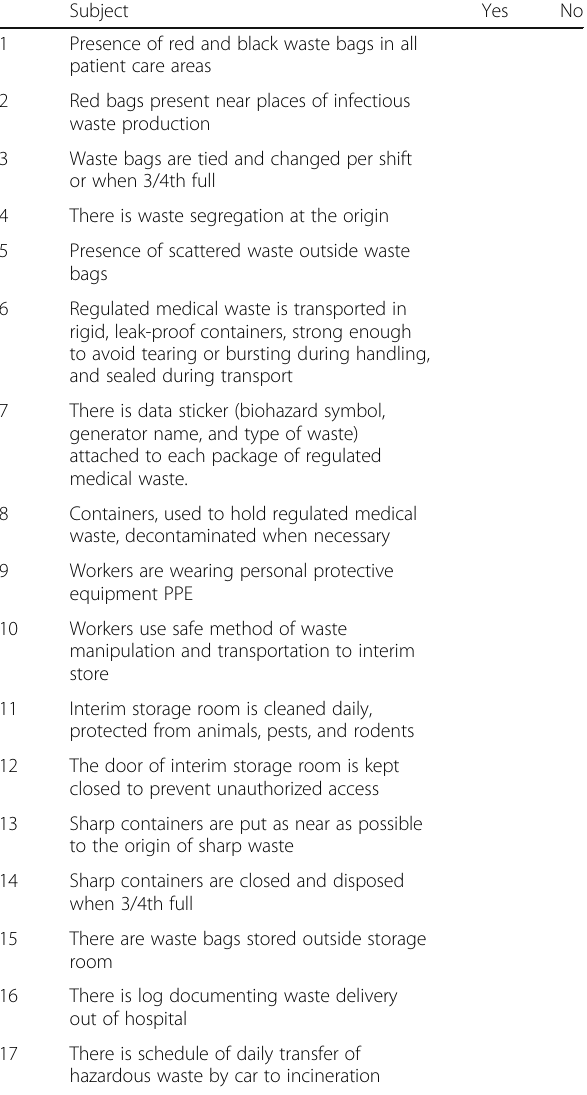
Table 2 Check list of performance of waste